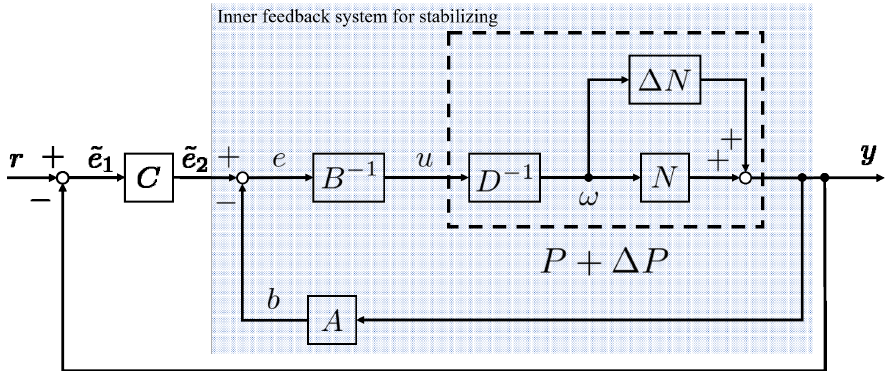
Figure 6. The operator-based nonlinear control feedback system.